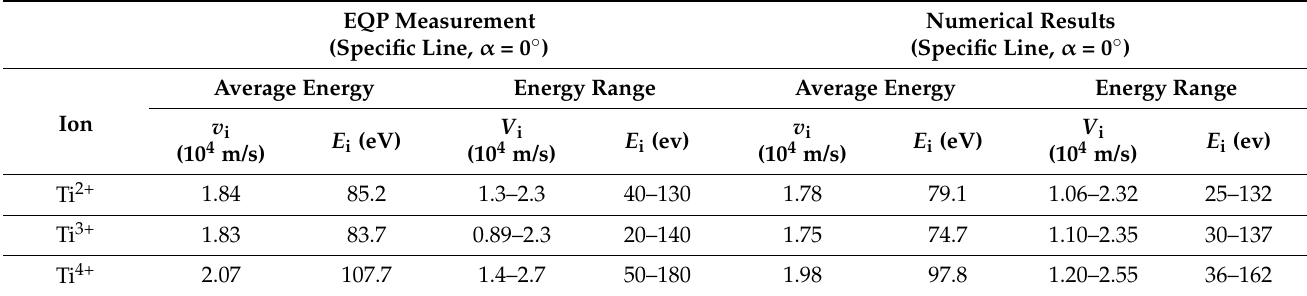
Figure 13. Schematic diagram of the plasma mass and energy analyzer. Table 2. Ion energy for different charge